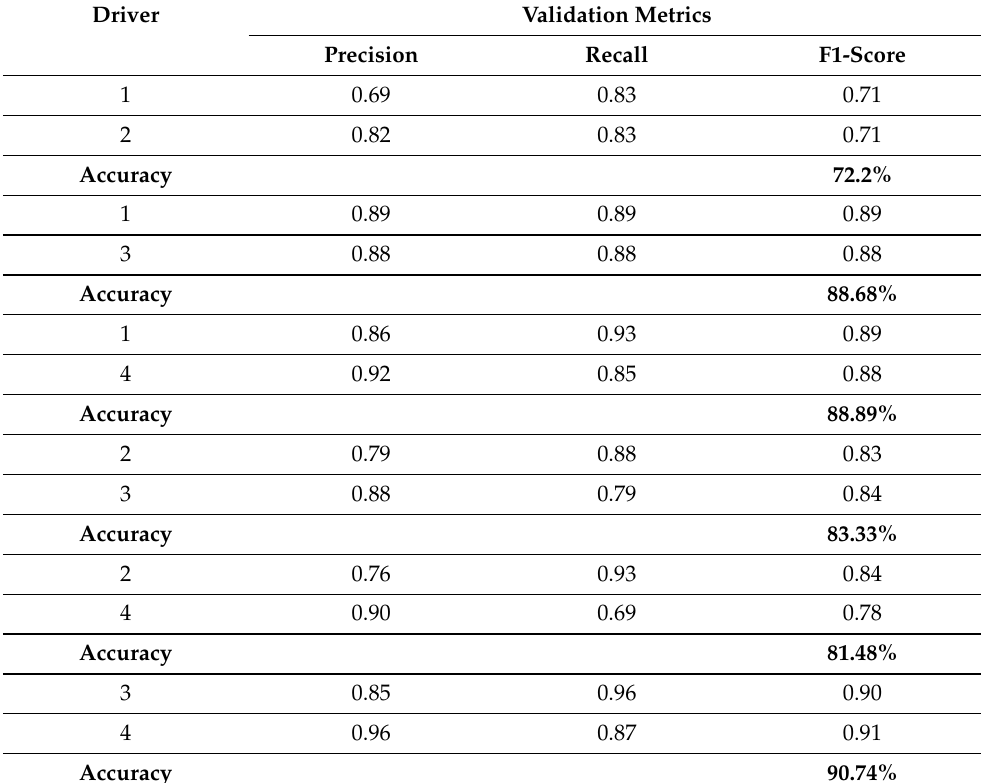
Figure 6. Forward selection method. The solid line represents average accuracy. Colored lines represent the accuracy per class. The best model is 4, which is formed from the first gene up to the seventh gene. Table 2. Validation Results With AG Features Selection for Two Driver Identification using